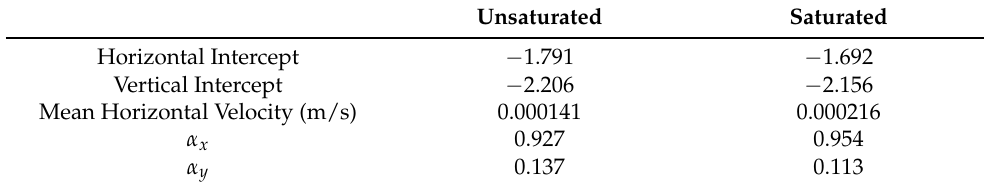
Figure 5. Plots showing the: ( a ) horizontal displacement of the streamlines over time ( b ) vertical displacement of the streamlines over time; ( c ) log-standard deviation of the horizontal displacement in the streamlines and ( d ) log-standard deviation of the vertical displacement in the streamlines. Table 1. The calculated dispersivity in each